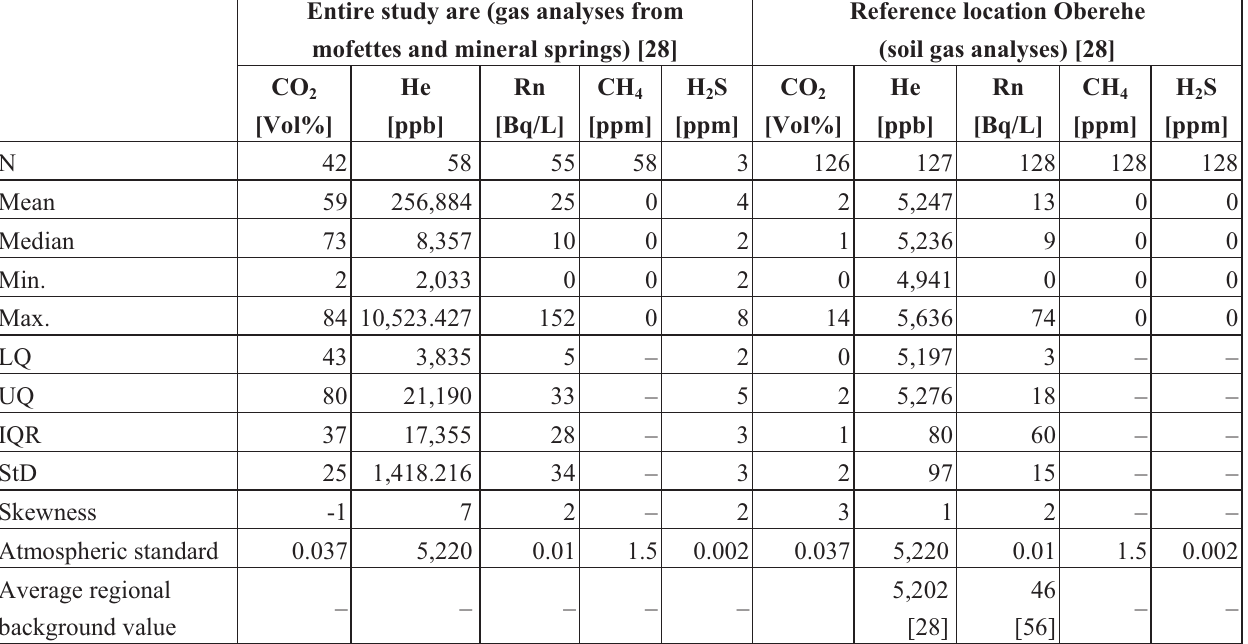
Table 2. Main statistical parameters of gas concentrations in the study area (mofettes and mineral springs) and at the reference location Oberehe (soil gas) (N = number of samples; LQ = lower quartile range; UQ = upper quartile range; IQR = interquartile range, StD = Standard